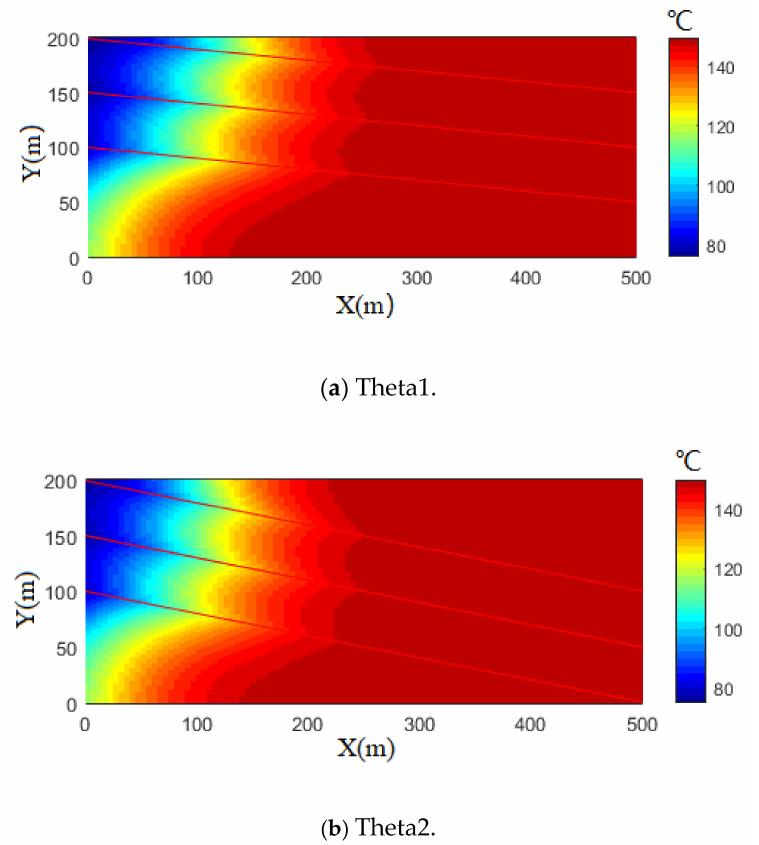
Figure 11. Temperature distribution for different fracture orientations (theta1 < theta2). Conpared with ( a , b ), an increase in the angle between flow direction and fracture orientation delays the thermal